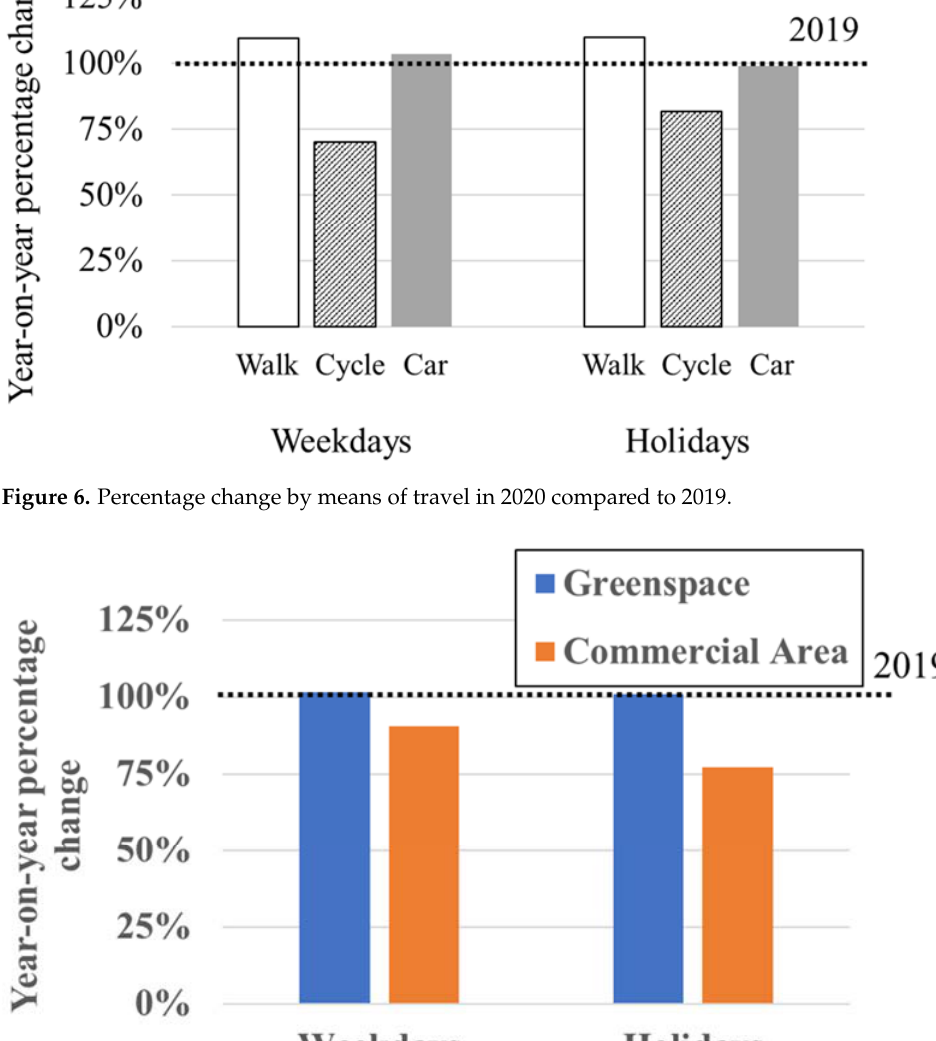
Figure 6. Percentage change by means of travel in 2020 compared to 2019.